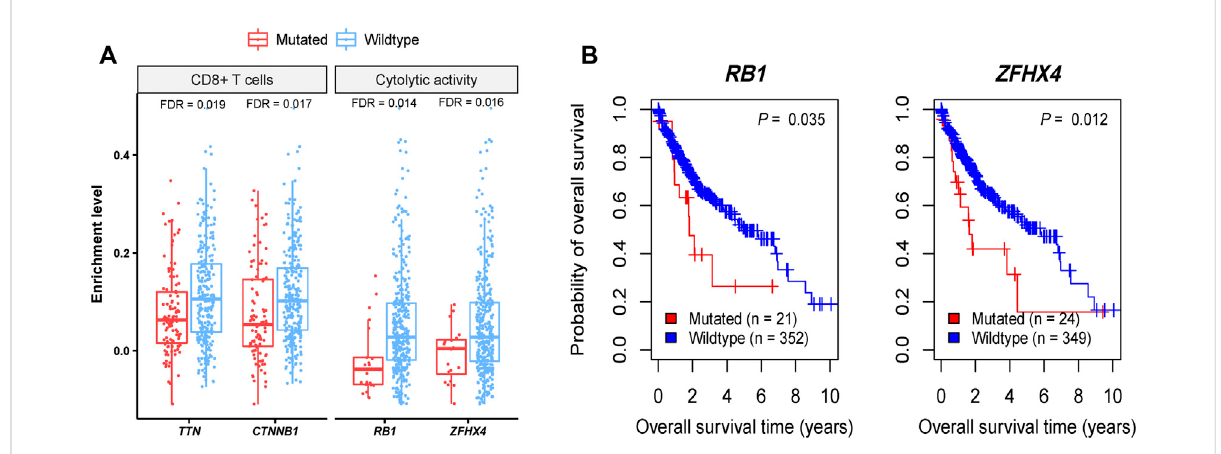
FIGURE 1 Four geneswhose mutations havesigni fi cantcorrelationswithreducedantitumorimmune responses inHCC. (A) Four geneswhose mutations arecorrelatedwithreducedCD8 + TcellenrichmentlevelsorcytolyticactivityinHCC. (B) Kaplan-Meiercurvesshowingtwoofthefourgeneswhose mutations are correlated with better overall survival in